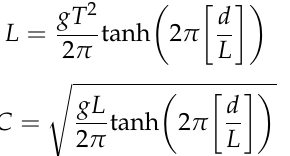
Figure 49. Comprehensive outcomes between rotor thrust and rotor RPM.